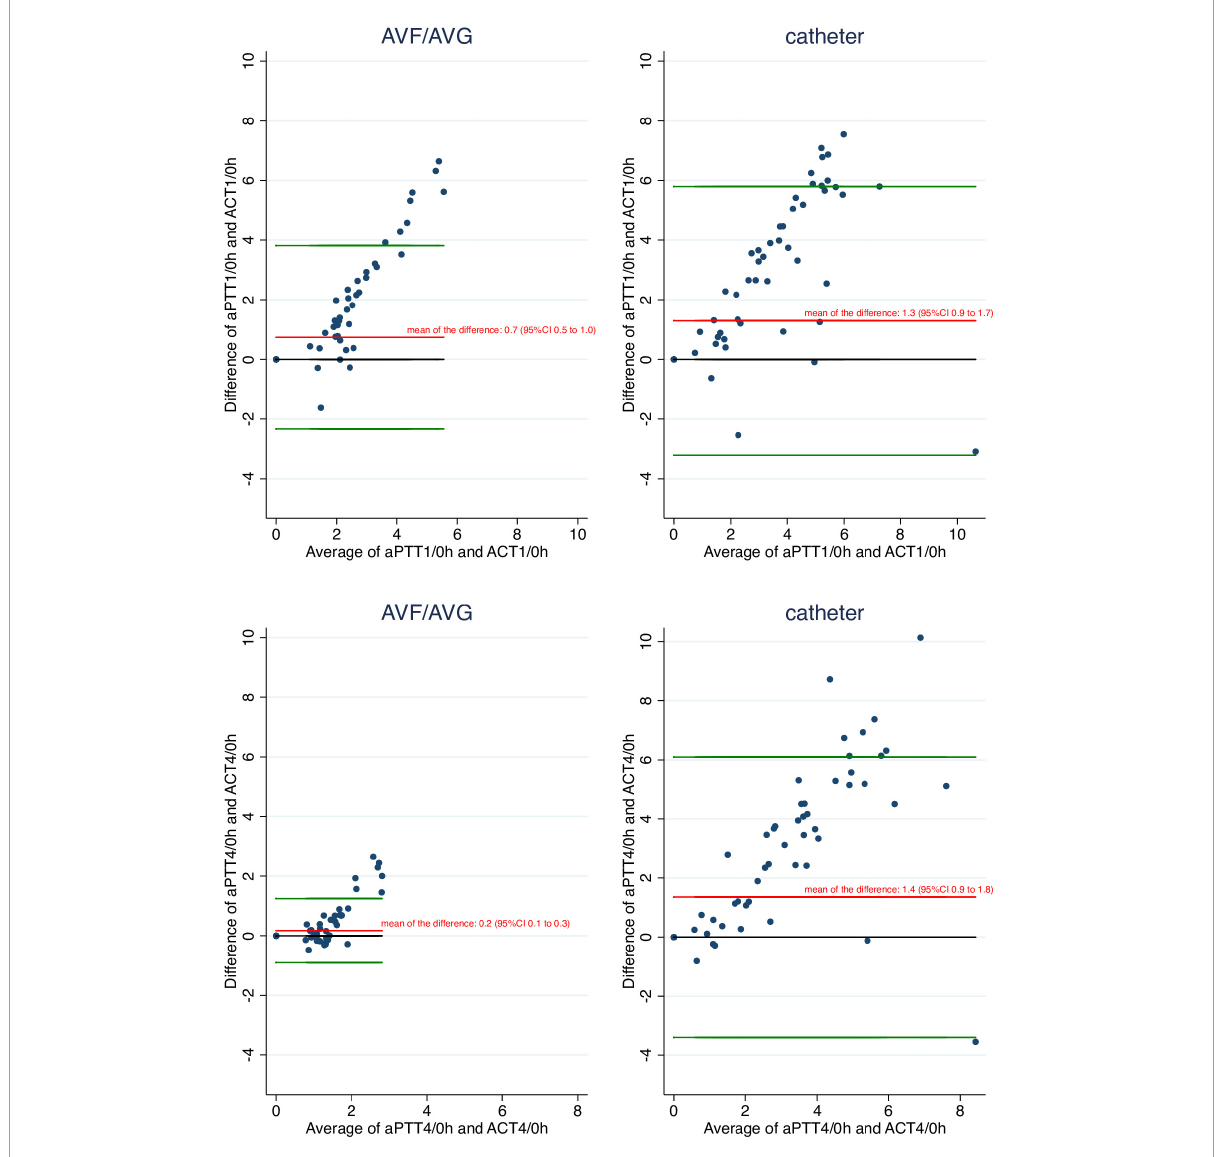
FIGURE5 Bland and Altman analysis comparing aPTT and ACT ratios according to vascular access. These Bland and Altman graphs show the difference between aPTT and ACT ratios over the average of aPTT and ACT ratios. Bland and Altman plots are shown for aPTT and ACT values 1 h after dialysis start over baseline (upper panel) and for aPTT and ACT values 4 h after dialysis start over baseline (lower panel) according to access